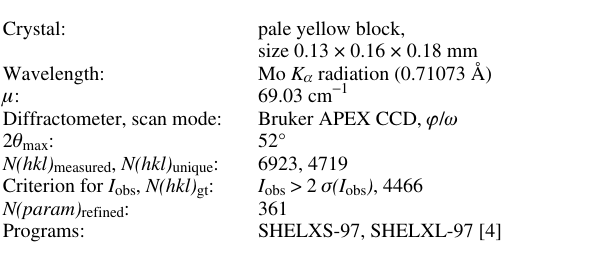
Table 1. Data collection and handling.